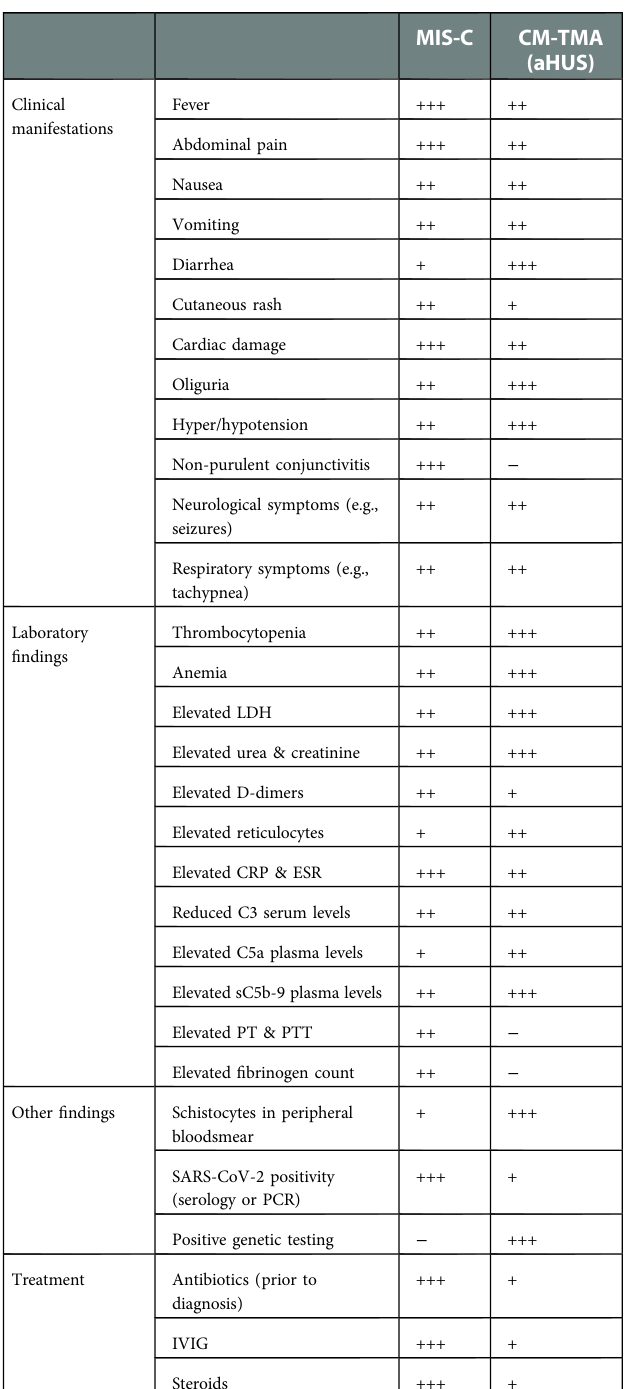
TABLE 1 Clinical, laboratory and treatment approach compared between MIS-C and aHUS (2, 5, 6, 9 –